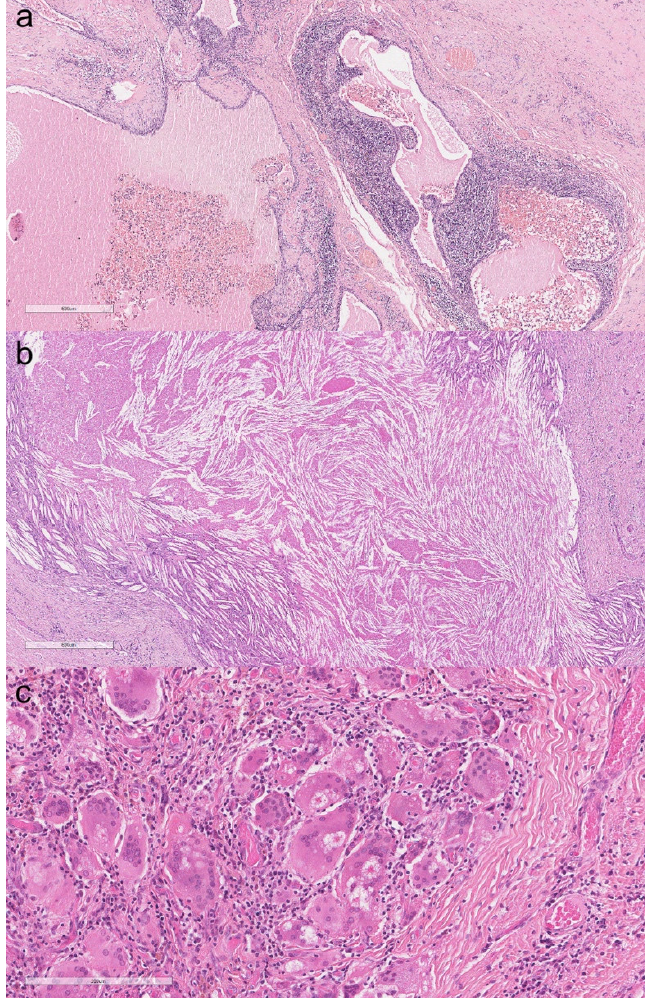
Figure 2. Multiloculated thymic cyst with thickened, fibrotic, and inflamed walls. The cystic spaces are filled with serum fluid and blood ( a , hematoxylin and eosin, original magnification ×40). Thymic cyst with cholesterol granuloma ( b , hematoxylin and eosin, original magnification ×40). Giant cell granuloma with several asteroid bodies around the wall of a thymic cyst ( c , hematoxylin and eosin, original magnification ×